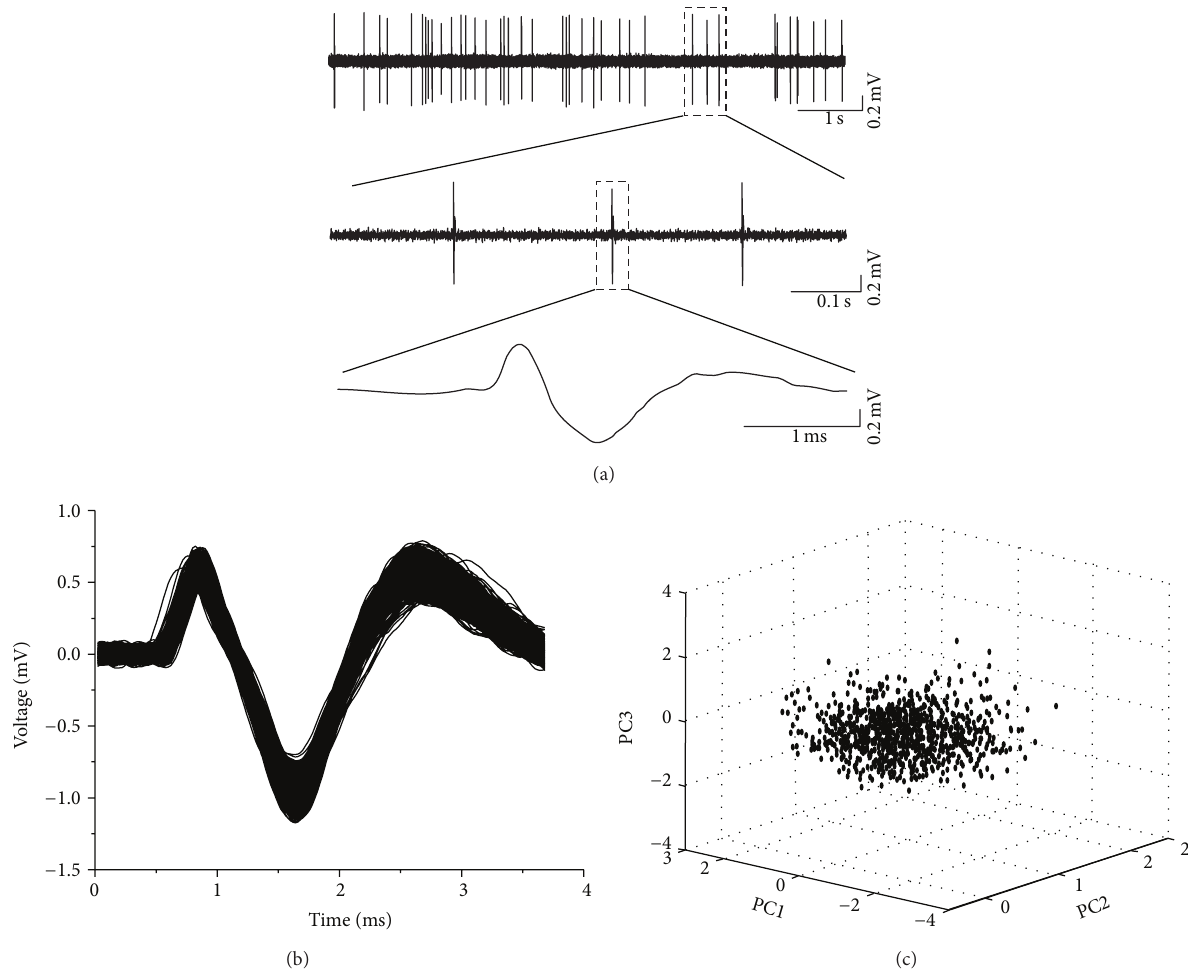
Figure 2: Recording and sorting of spontaneous discharge of EC neurons. (a) Single unit spontaneous discharge recorded in EC neurons (upper). The lower two panels are the enlargements of the indicated regions in the upper panel. (b) The overdrawn waveforms of firing events during a 30min period form one cluster, indicating that all of the spikes were from one neuron. (c) Offline classification of spikes with principle component analysis (PCA). Every spike shown in (b) is projected onto the PCA-feature space shown in (c), further indicating that all of the spikes were from one